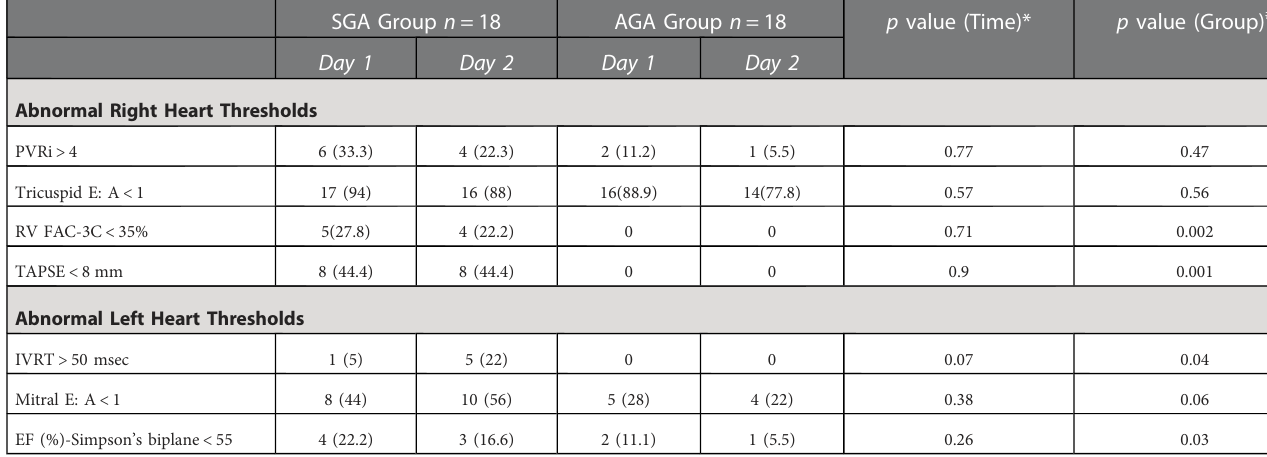
TABLE 4 Frequency of abnormal hemodynamic thresholds for SGA infants compared to term neonates during transitional